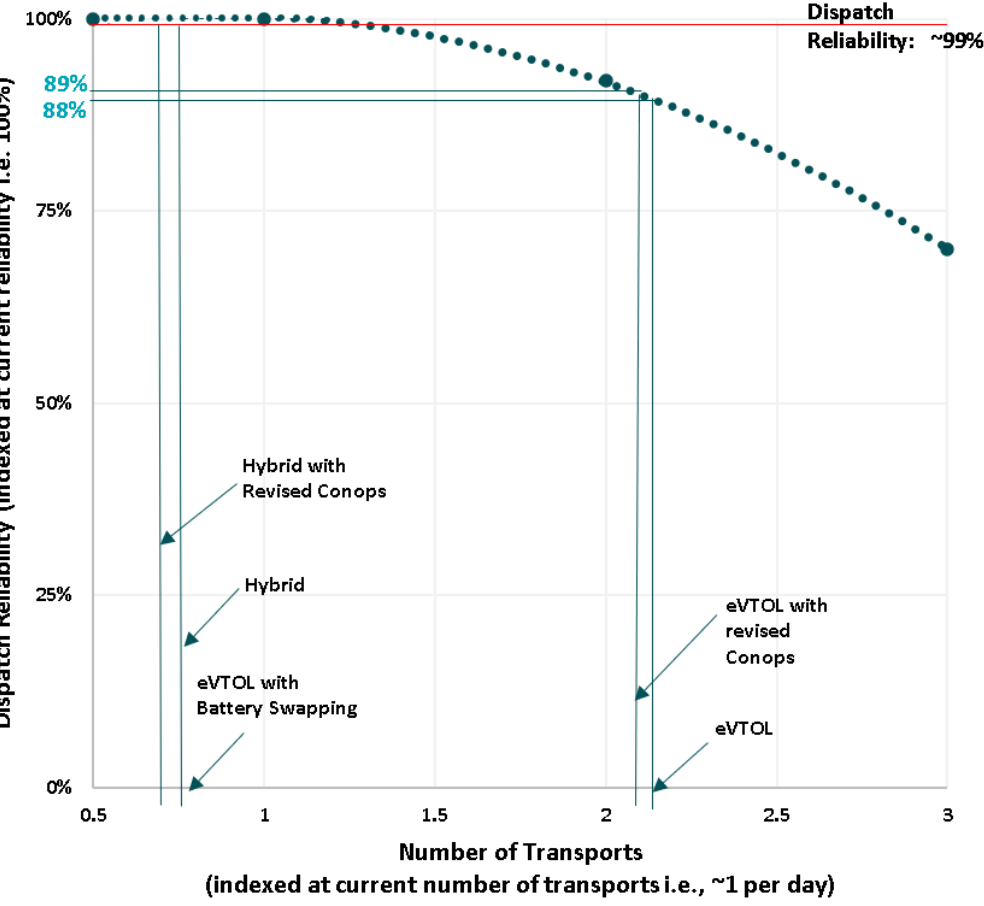
Figure 10. Dispatch reliability on air ambulances.